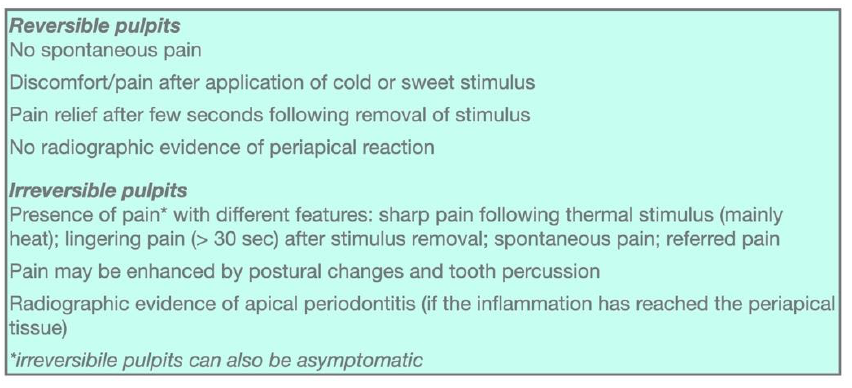
Figure 2. Endodontic diagnosis procedure.